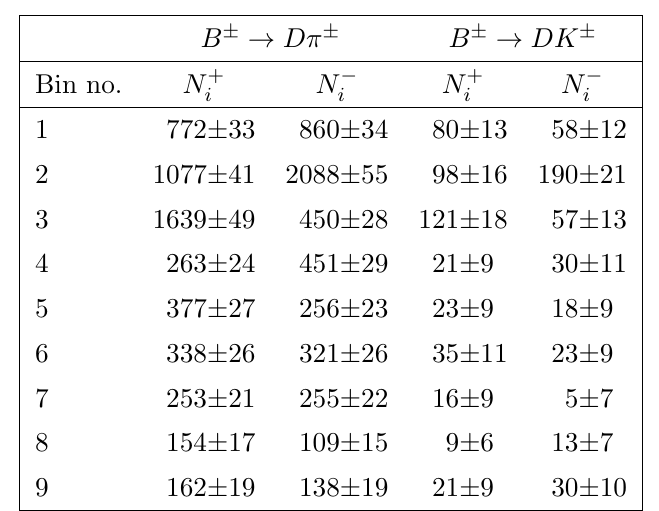
Figure 5 . Signal-enhanced (cid:12)t projections of (a) (cid:1) E and (b) C 0 for the B (cid:6) ! DK (cid:6) data sample NN in bin 1. The black points with error bars are the data and the solid blue curves are the total (cid:12)t. The dotted red, blue, magenta, and green curves represent the signal, continuum, combinatorial BB backgrounds and cross-feed peaking background components, respectively. The pull between the data and the (cid:12)t is also shown for both the projections.